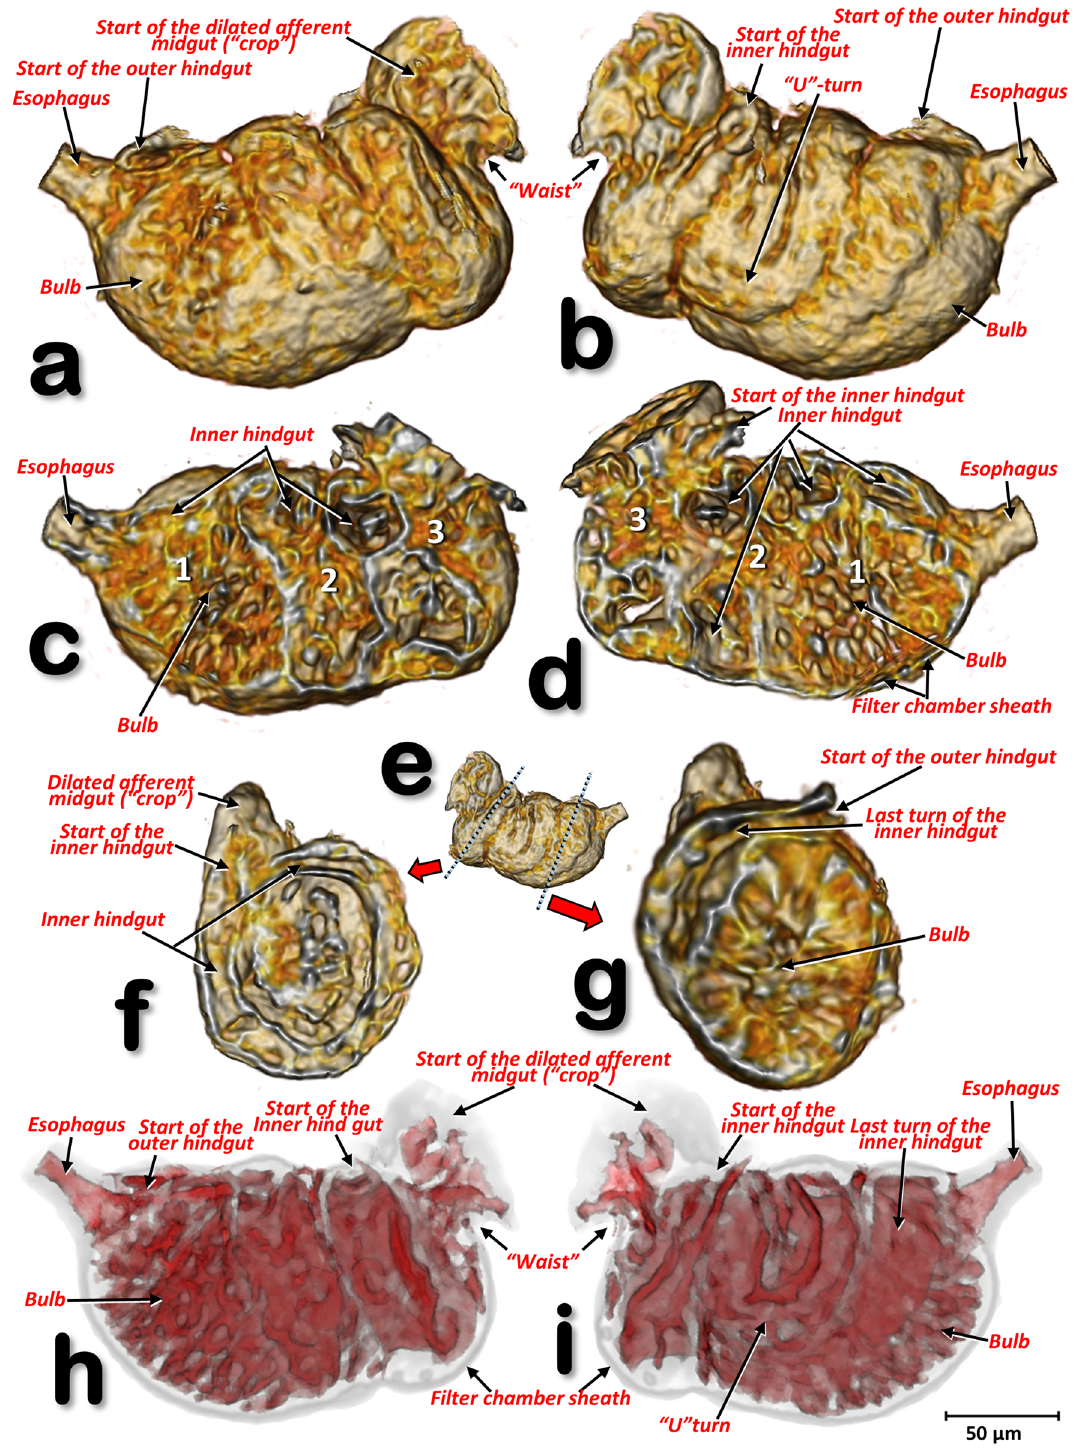
Figure 14. Volume-rendered close-up images of the filter chamber of a male Diaphorina citri , in different perspective views: left-lateral ( a , c , h ), right-lateral ( b , e , i ). Internal structure views after virtual cuts: sagittal ( c , d ), transverse ( f , g ) through positions marked with blue dotted lines in ( e ), and reconstruction of the cavities (spaces) inside the filter chamber ( h , i